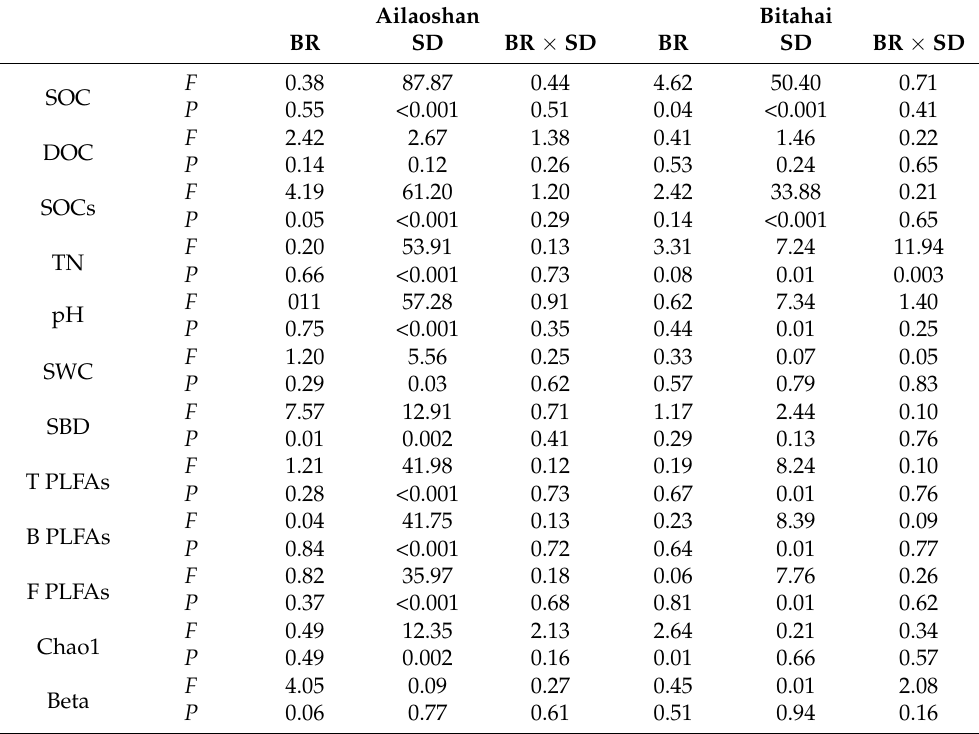
Table 1. Bryophyte removal and soil depth were used for two-way ANOVA in the two forests. Ailaoshan